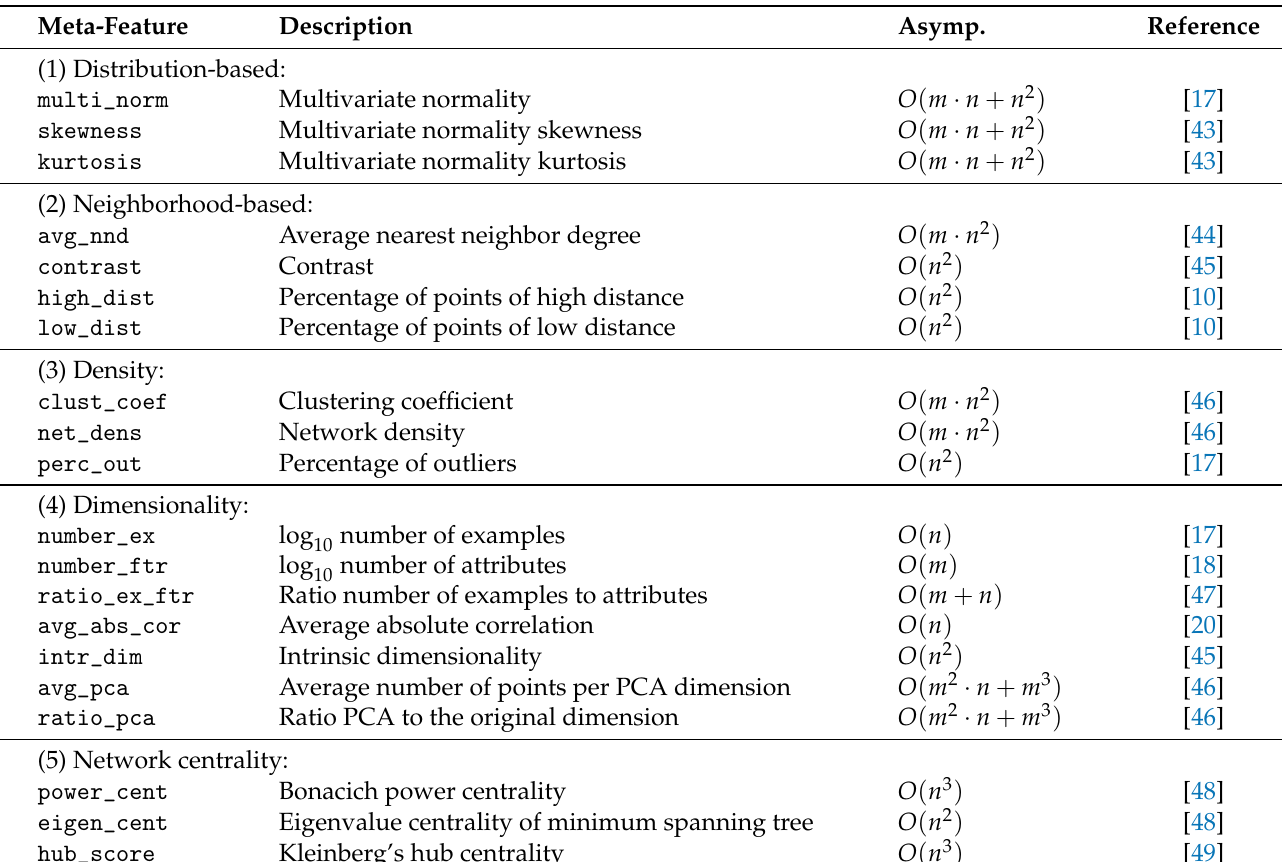
Table 1. Meta-features classified by the main properties they measure. In the Asymp. column, n stands for the number of data items a dataset has and m corresponds to its number of input